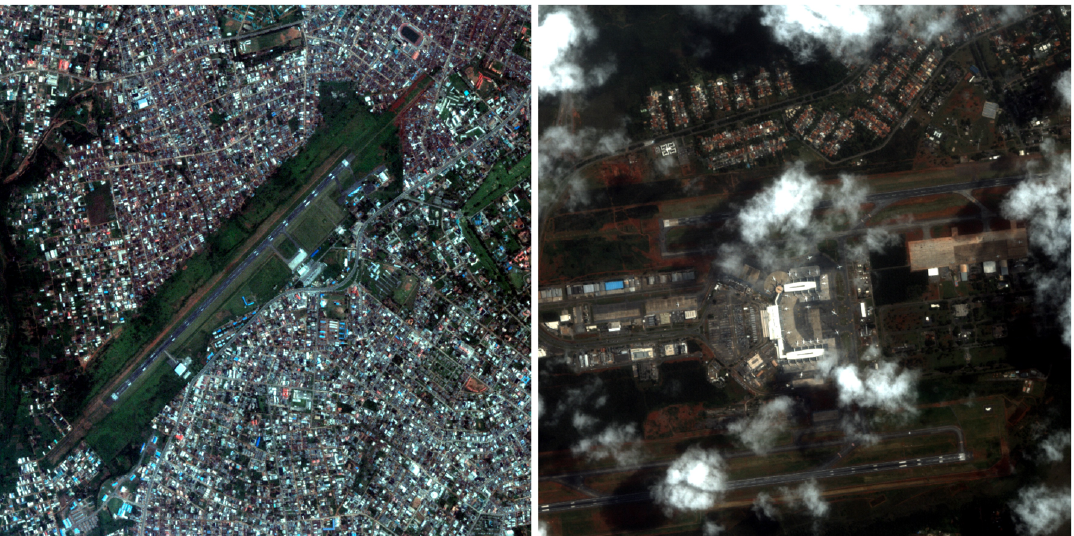
Figure 2. Two examples of data from the Carbonite-2 satellite. The left-hand pane shows a scene from Benin, and the right-hand pane is over an area in Brazil. Data provided by Surrey Satellite Technology Ltd. and Earth-i